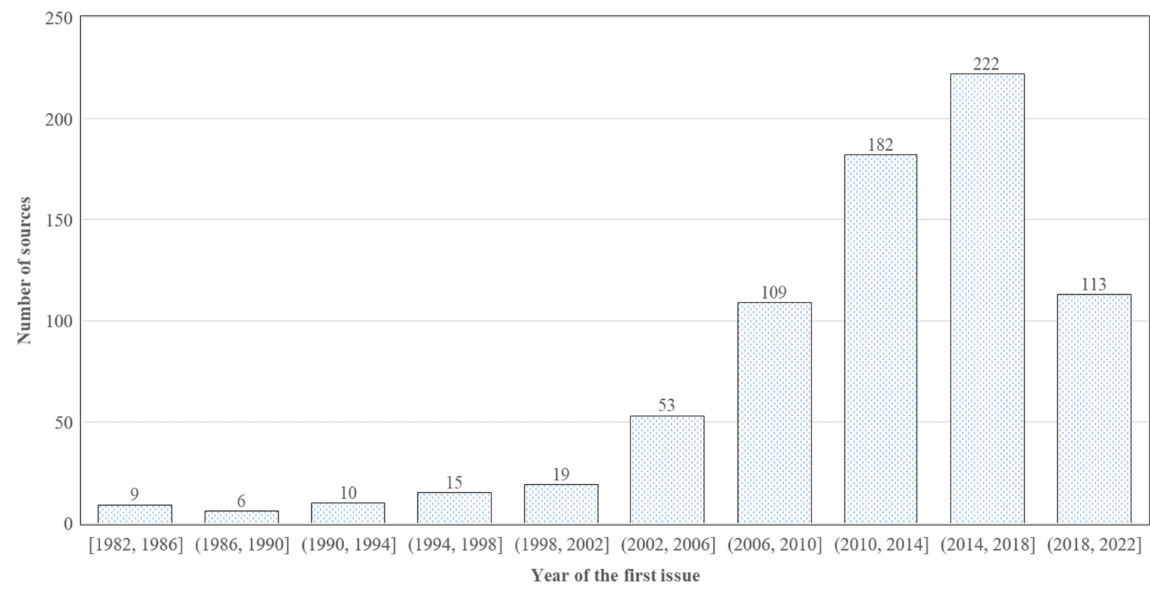
Figure A1. Distribution of non-cited documents.